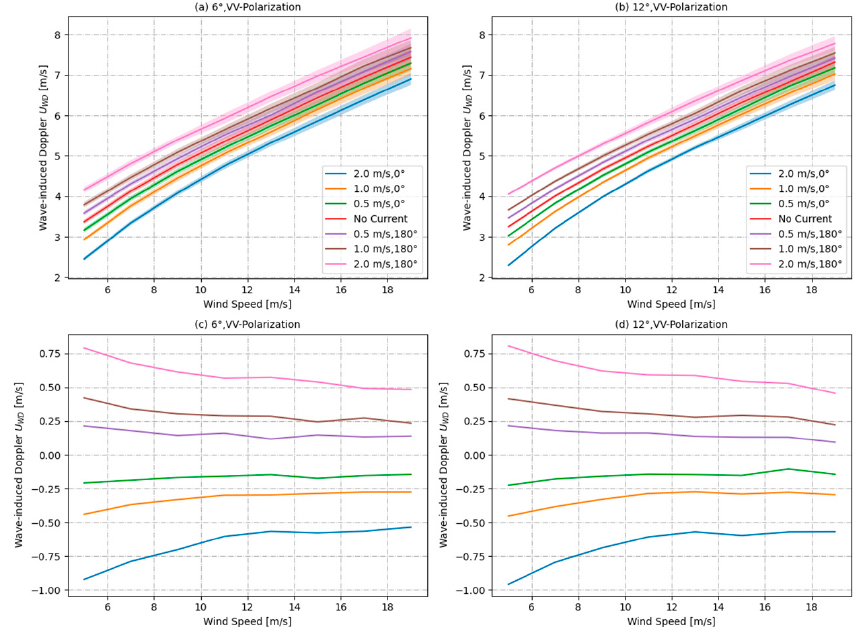
Figure 22. ( a , b ) represent the variation in U WD with wind speed for radar incidence angles of 6 ◦ and 12 ◦ , wind speed of 10 m/s, and sea surface currents of 0.5, 1, and 2 m/s when they are in downwind and upwind directions, respectively. The colored solid lines indicate the U WD , and the corresponding colored shading is the standard deviation. ( c , d ) correspond to ( a , b ) and indicate the difference in U WD between the presence and absence of current.